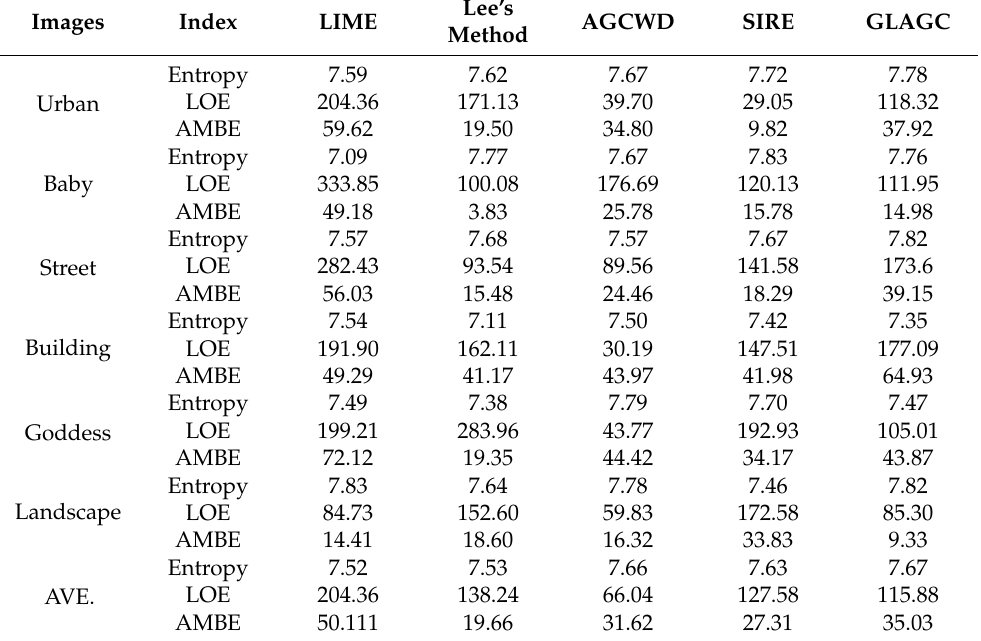
Table 1. Quantitative comparisons of different methods in terms of the entropy, LOE and AMBE. Images